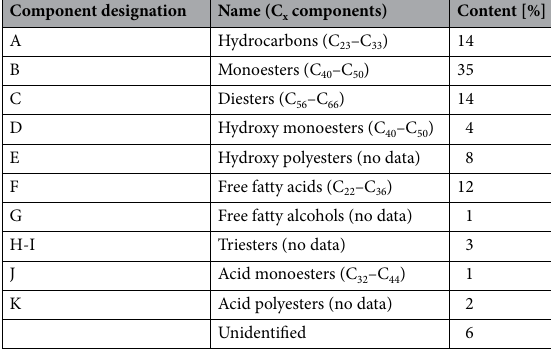
Table 1. Composition of beeswax 31,32